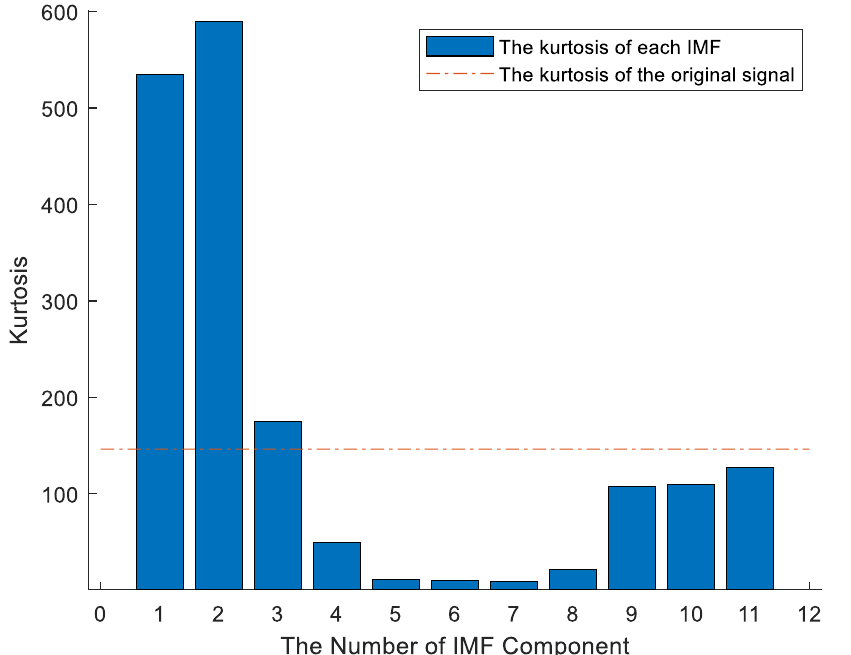
Figure 9. Envelope kurtosis values of each component and original